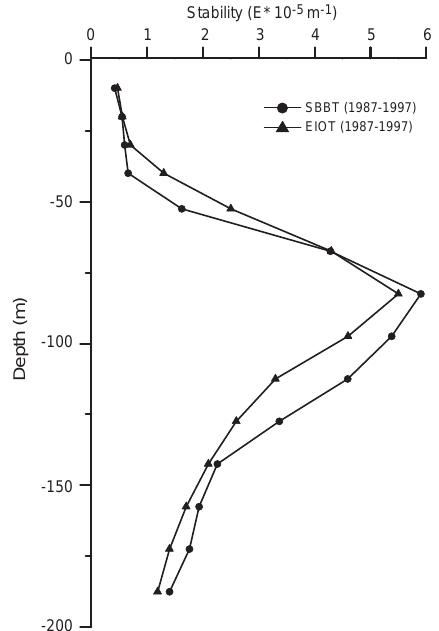
Fig. 7. Monthly mean climatology (1987–1997) of static stability of the water column (m − 1 ) at SBBT (filled circle) and EIOT (filled triangle) (see text for details) during August.